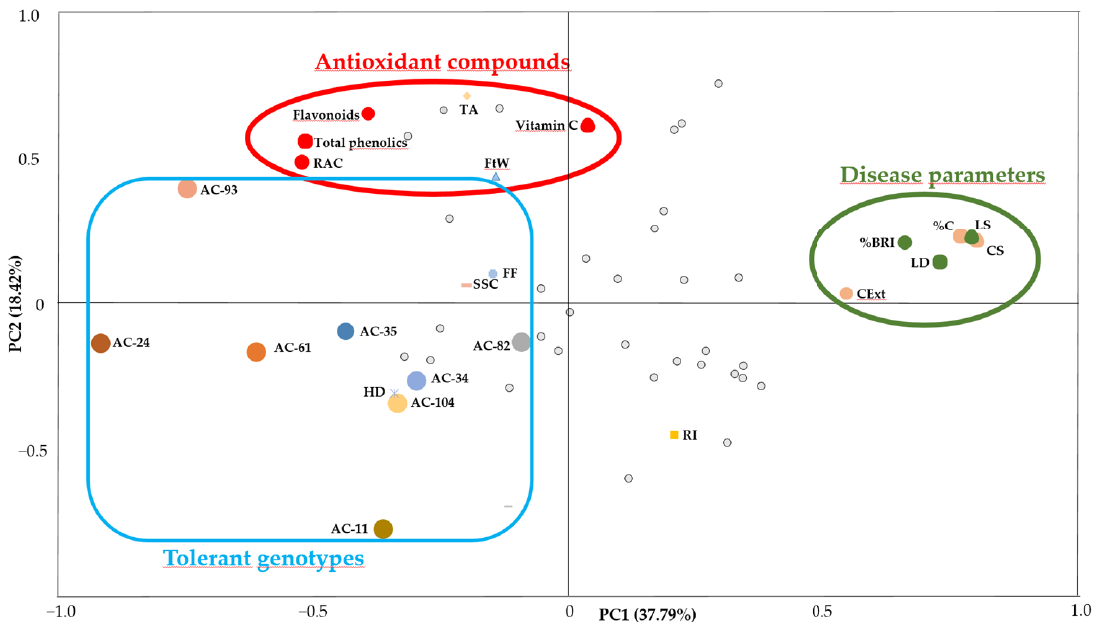
Figure 1. Principal Component Analysis (PCA) of forty-two genotypes from the ‘Andross’ × ‘Calante’ population evaluated in 2014 and the studied variables. The eight selected genotypes are represented as (AC-). Open circles correspond to the rest of the evaluated genotypes. Relevant traits are labeled. The red oval groups the antioxidant parameters (vitamin C, total phenolics, flavonoids and RAC), the antioxidant capacity; BRI = Brown Rot Incidence; LD = Lesion diameter; LS = Lesion severity; C = green the disease parameters (%BRI, LD, LS, %C, CExt and CS) and the blue square the eight selected Colonization; CExt = Colonization extent; CS = Colonization severity CExt = Colonization extent; CS genotypes. Abbreviations as indicates in Tables 1, 3 and 5. = Colonization severity.